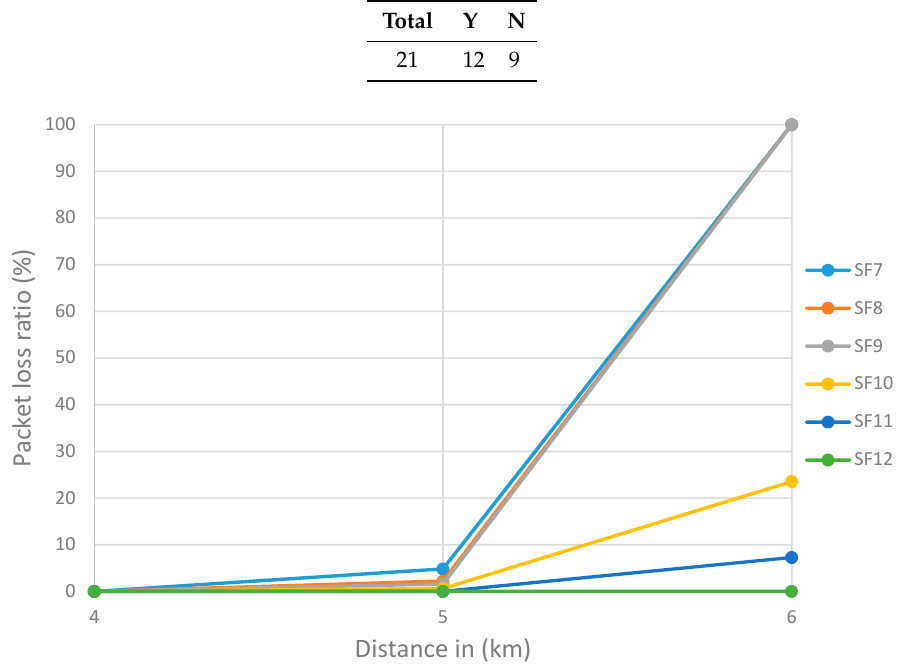
Table 4. Summary of the numbers of successfully and unsuccessfully received images.